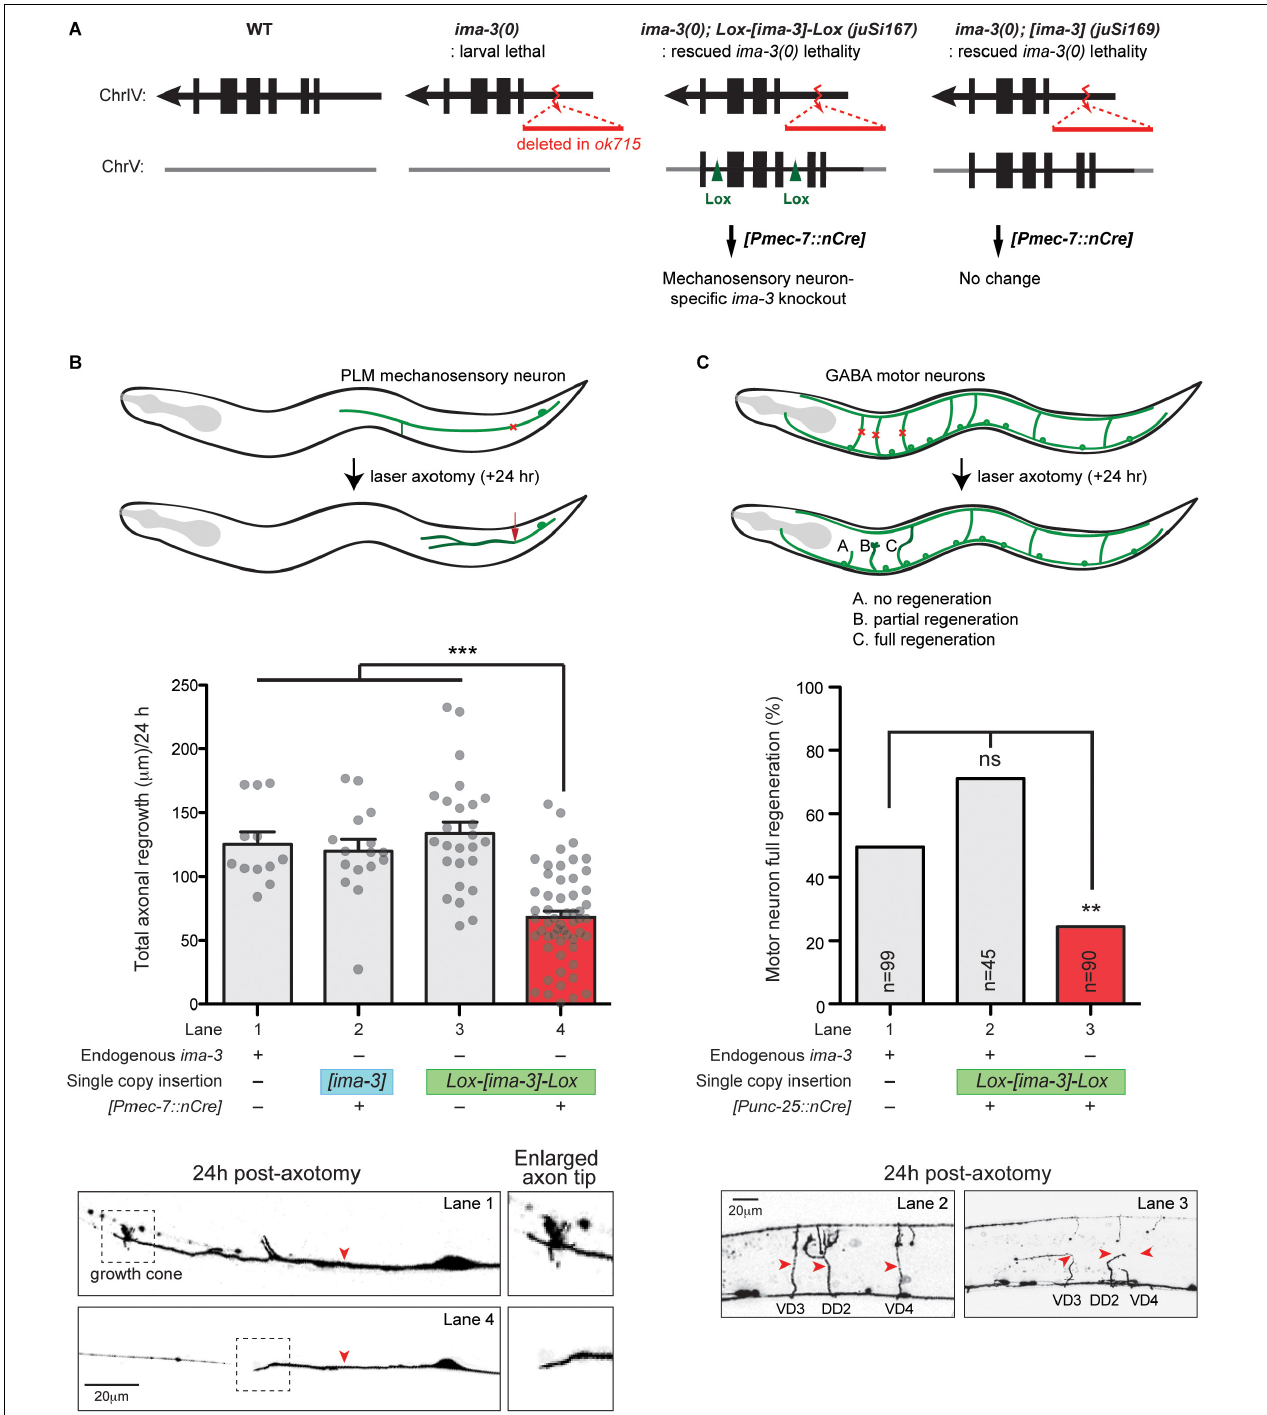
FIGURE 6 | ima-3 is required cell autonomously for PLM axon regeneration. (A) Schematic illustration of a strategy to generate ima-3 mutation in mechanosensory neurons. The lethality of ima-3(ok715) is rescued by juSi167[Lox2272-flanked ima-3 gDNA] or juSi169[ima-3 gDNA] . Both juSi167 and juSi169 were crossed to Pmec-7::nCre , which deletes transgenic IMA-3 in mechanosensory neurons in juSi167, but not juSi169 animals. (B) PLM axon regrowth 24 h post-axotomy in ima-3(ok715) mutation in mechanosensory neurons. One-way ANOVA followed by Tukey’s multiple comparison test. Data are shown as mean ± SEM. ∗∗∗ p < 0.001. Bottom: representative images of PLM axons 24 h post-axotomy. Red arrowhead, site of axotomy. (C) GABAergic motor neuron full regeneration 24 h post-axotomy in ima-3(ok715) mutation in GABAergic motor neurons. Fisher’s exact test, two-tailed. Data are shown as mean. n, number of animals shown within columns. ns, not significant; ∗∗ p < 0.01. Bottom: representative images of motor neurons (VD3, DD2, VD4) 24 h post-axotomy. Red arrowhead, site of axotomy.